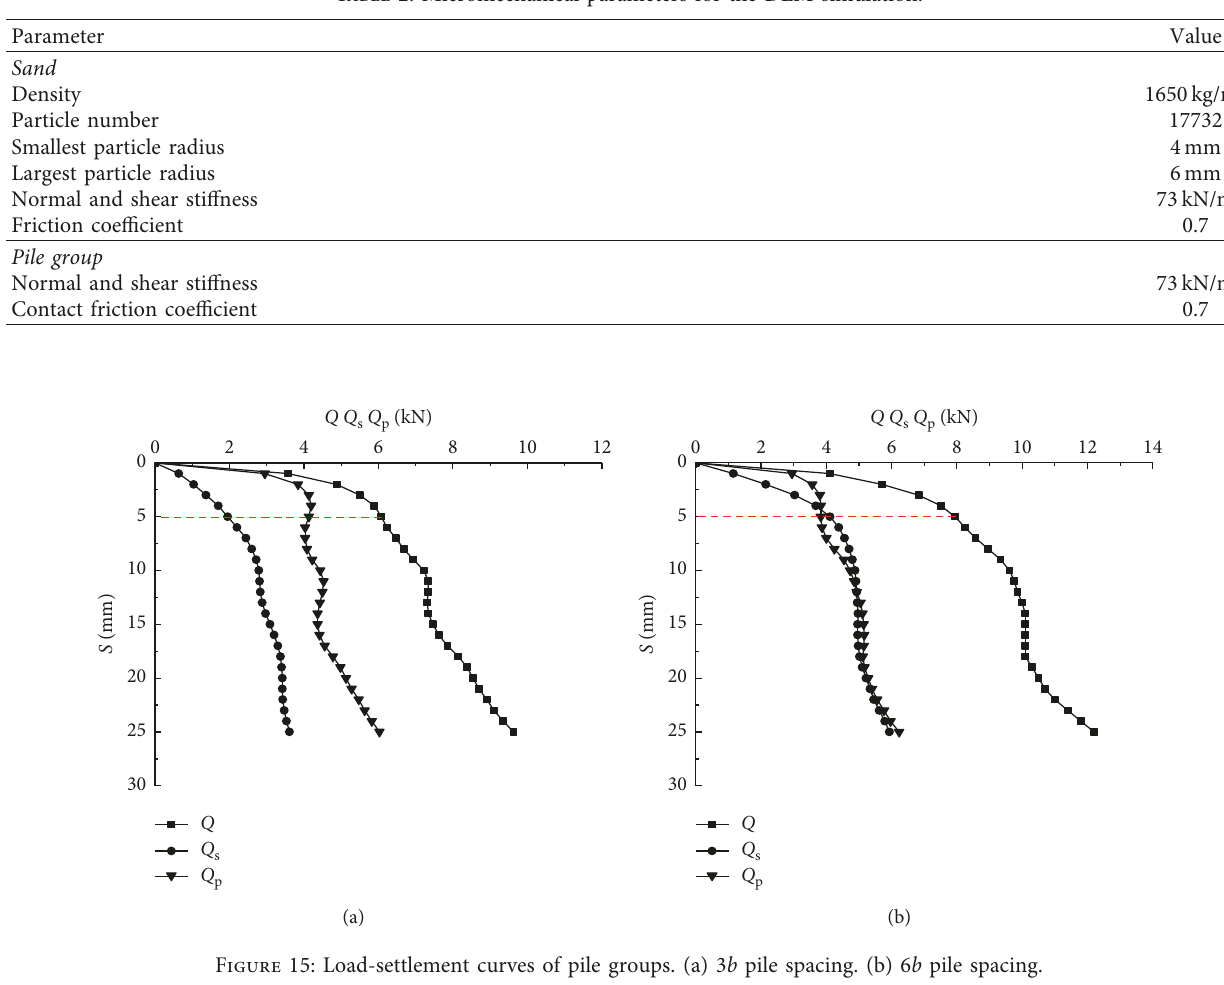
Table 2: Micromechanical parameters for the DEM simulation.